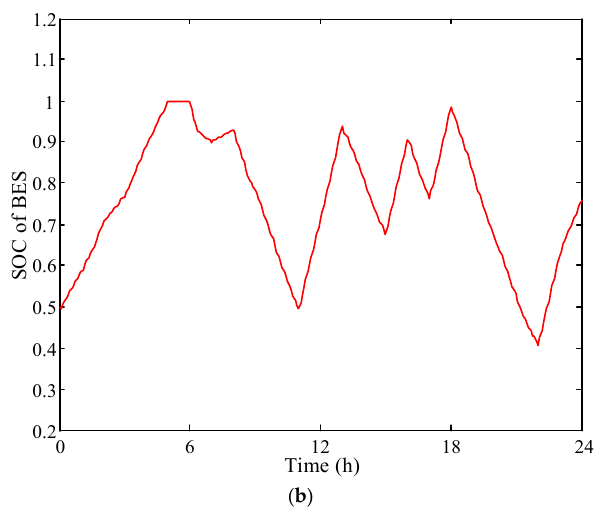
Figure 9. Operation results of the BES and DRA in HAS and RTS: ( a ) Power of the BES and DRA in HAS and RTS; ( b ) SOC of the BES in RTS.